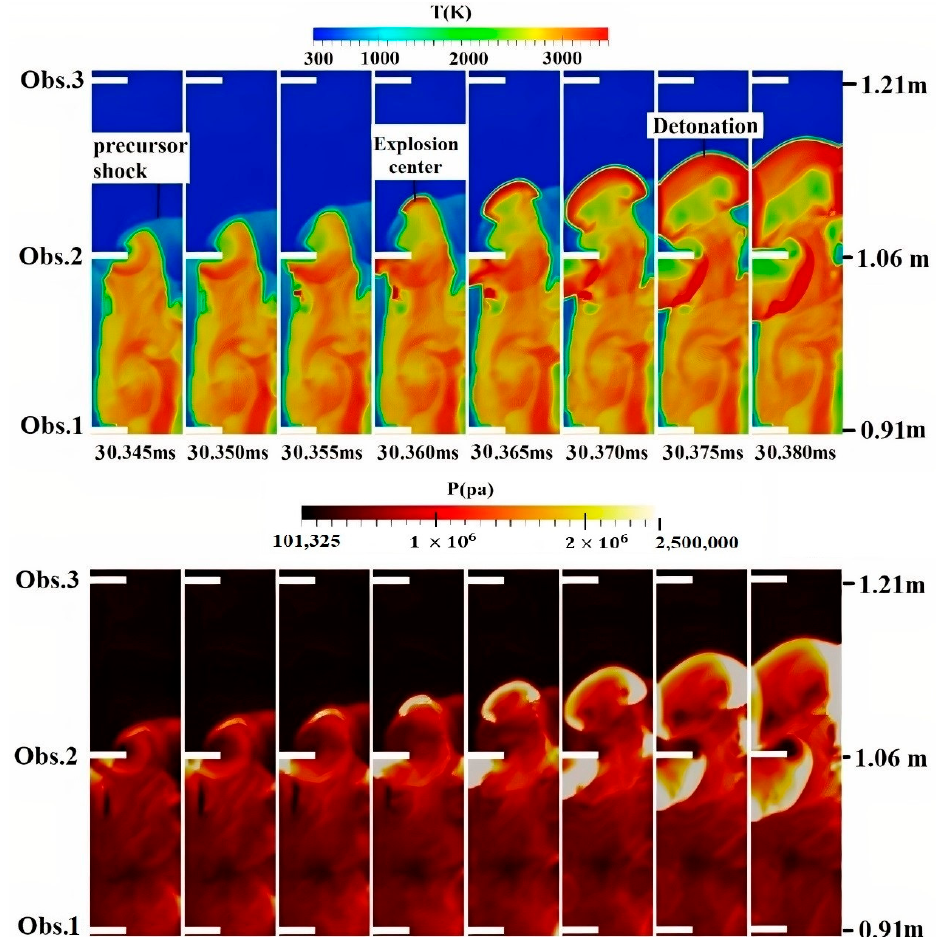
Figure 11. Temperature and pressure contours for the propagation of flame in H 2 –air mixture with 30% hydrogen concentration .